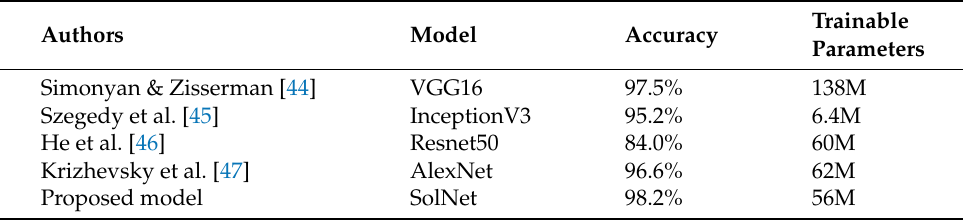
Table 9. Comparison of average testing accuracy for SOTA models and SolNet on our